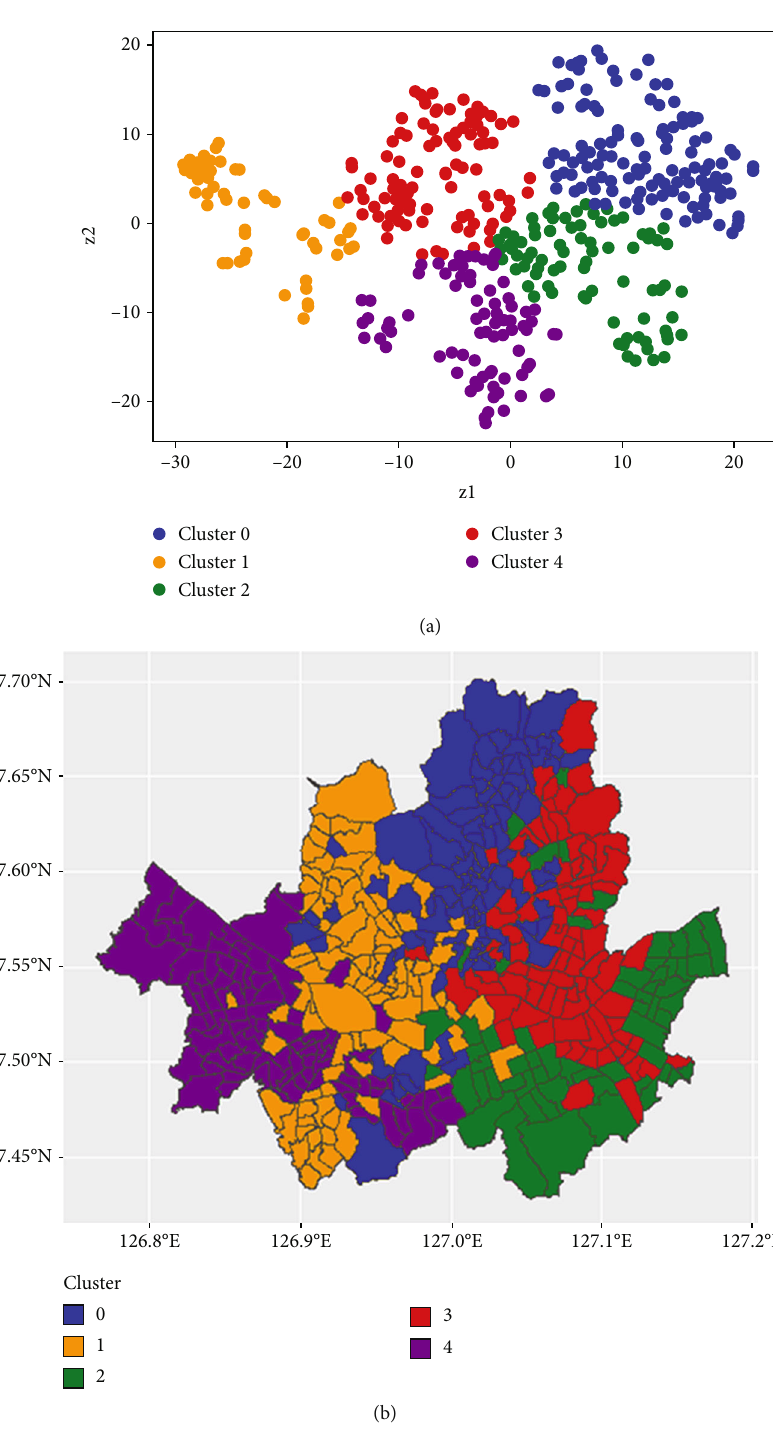
Figure 6: Results for the functional similarity adjacency matrix obtained using t-SNE: (a) t-SNE results for the functional similarity; (b) t-SNE results for the Seoul